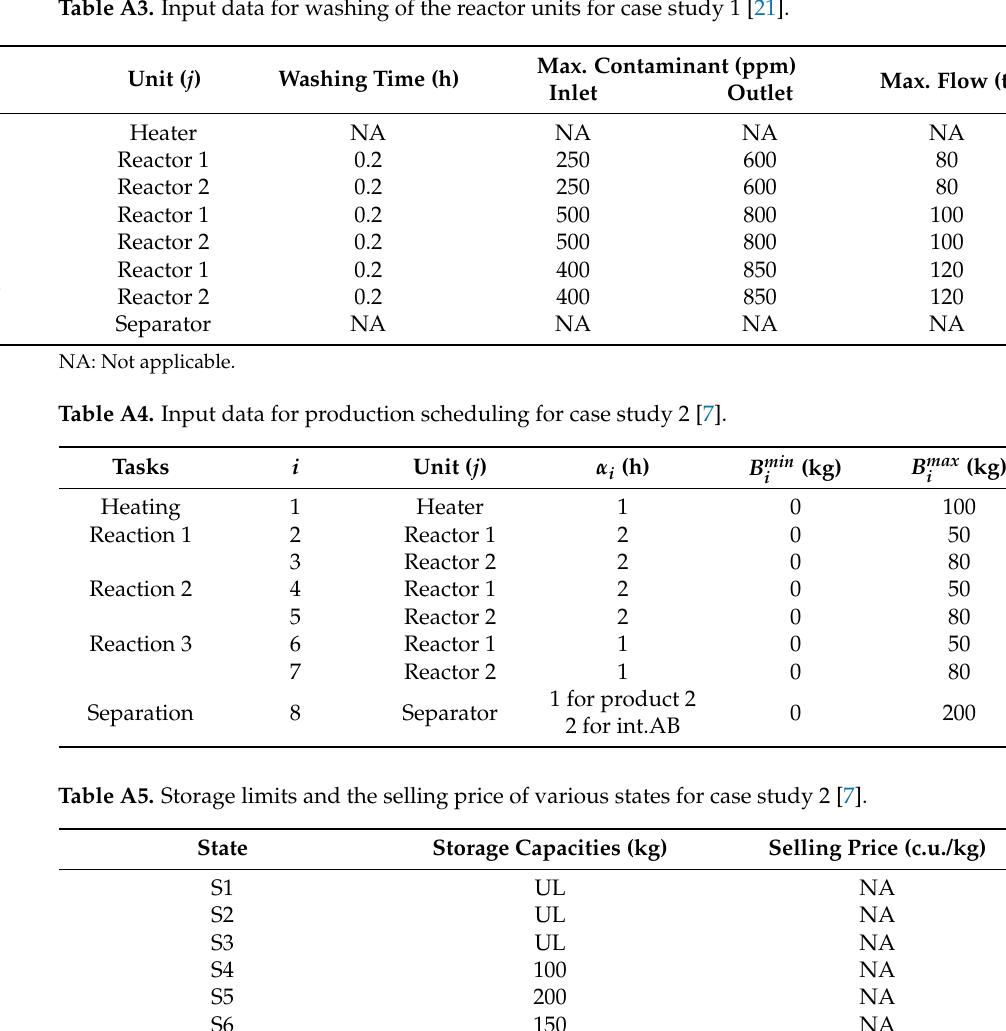
Table A3. Input data for washing of the reactor units for case study 1 [21].